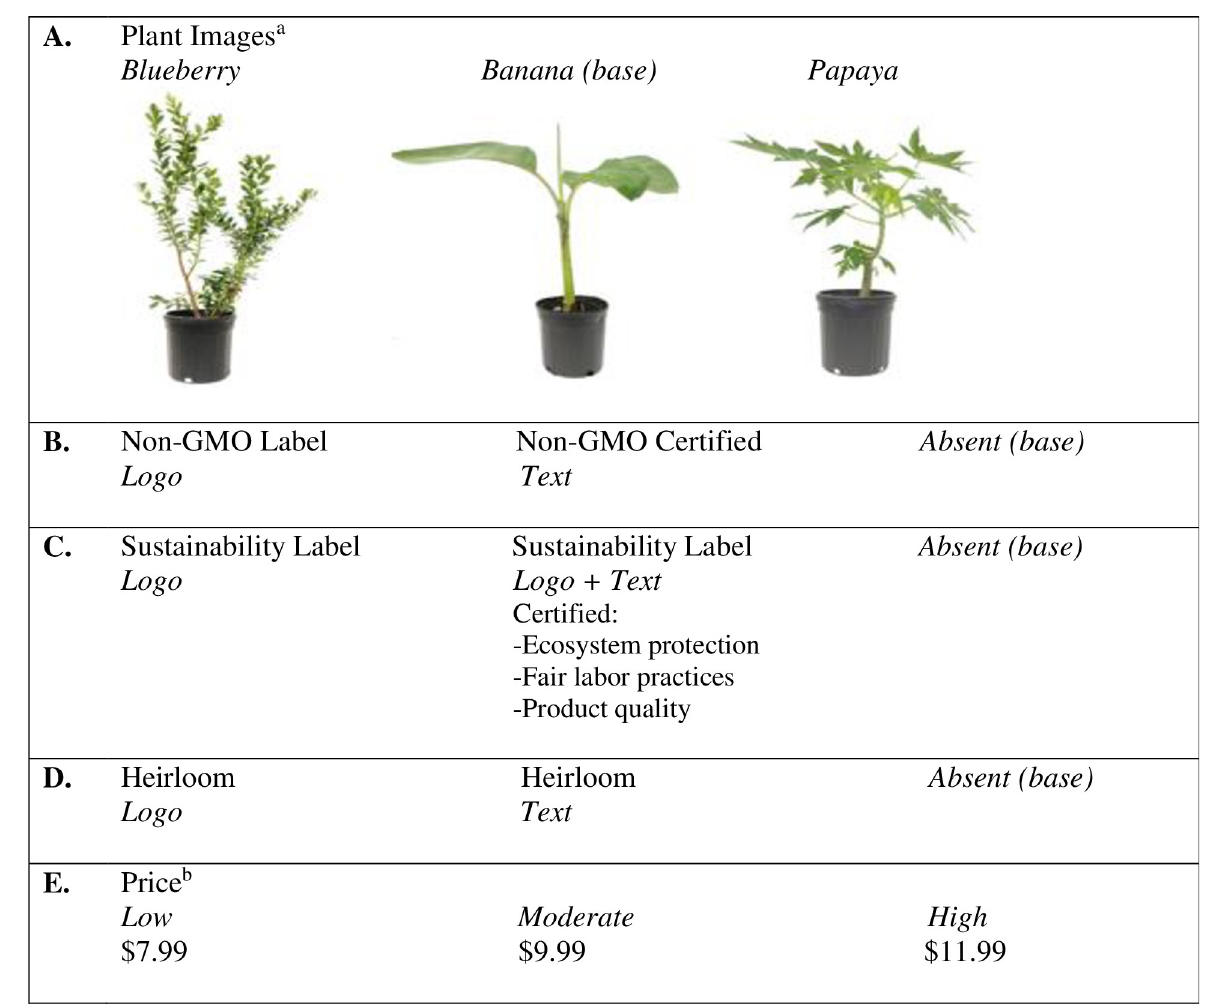
Fig 1. Attributes and attribute levels used in the experimental design. A. Indicates the plant images shown to participants; B. Shows the non- GMO label options; C. Shows the sustainability labels; D. Shows the heirloom labels; and, E. Are the price points used in the choice experiment. a The plants used in the experiment were photographed by the authors and were not previously copyrighted. b Price was only provided in the choice experiment while experimental auction participants bid the amount they were willing to pay. Prices were determined based on marketplace price points observed at various retail outlets in Florida. For the experimental auction, the plants were purchased at the $9.99 price point which was used as a reference point when determining the prices in the choice